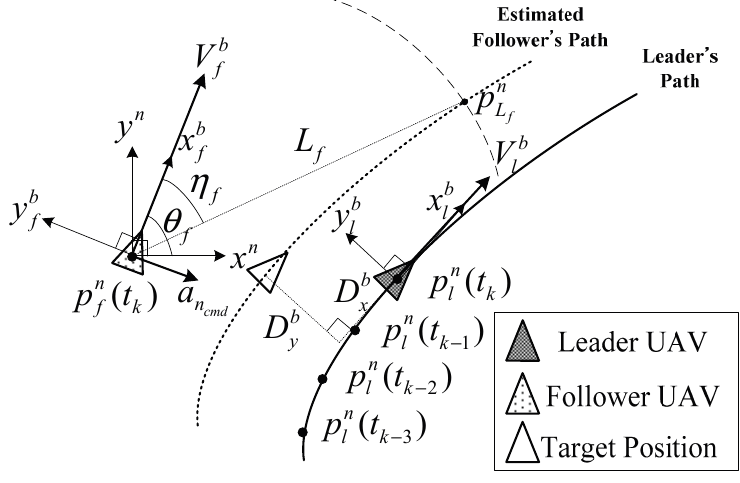
Figure 11. Formation path generation of a follower